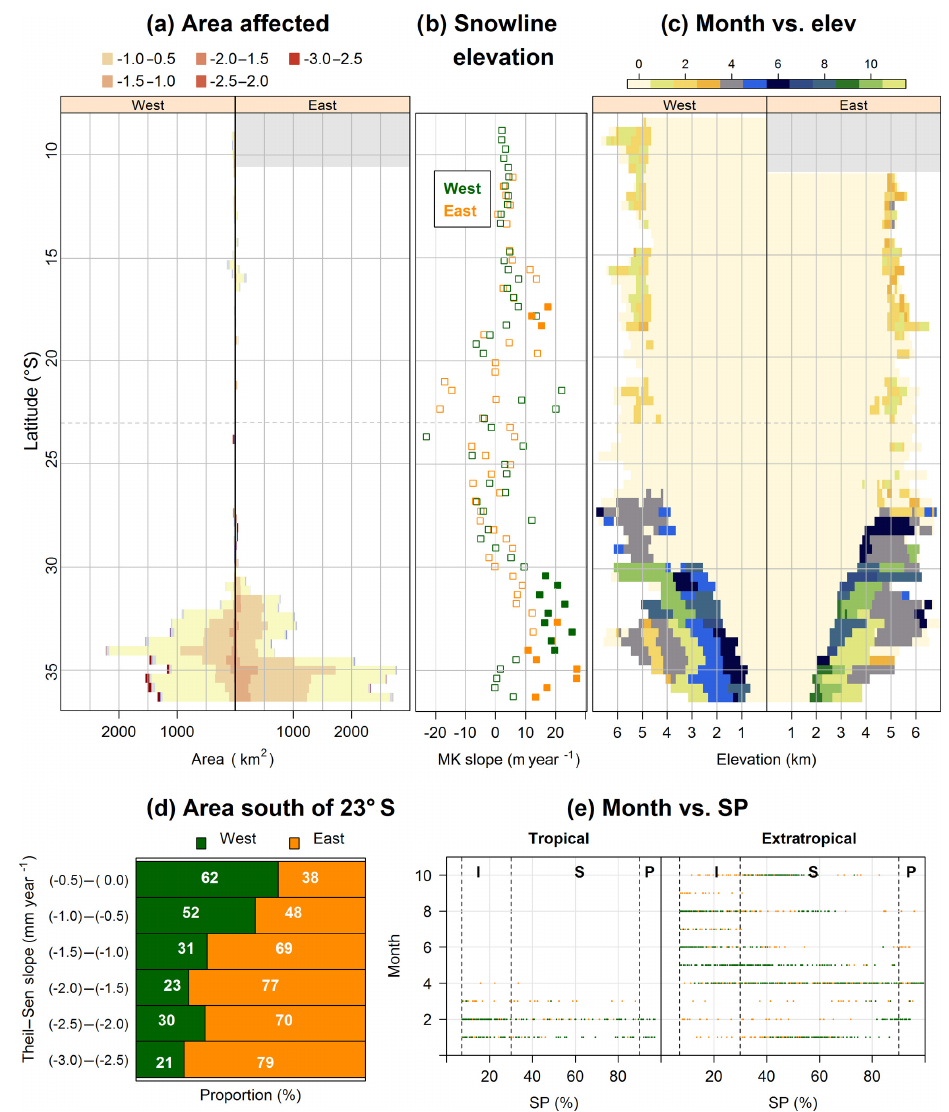
Figure 5. (a) Areas with significant trends in annual SP by side of the continental divide (west–east) and latitude band; (b) rate of change (Theil–Sen slope) in the elevation of the snowline (SP = 20%), where solid symbols have significant trends ( p ≤ 0.05); (c) months with the highest significant Theil–Sen slope from the Mann–Kendall trend analysis of monthly SP; (d) percent of area in each Theil–Sen slope category for west and east sides; and (e) months with greatest SP rate of change (slope) in tropical (north of 23 ◦ S) and extratropical (south of 23 ◦ S) latitudes for west (green) and orange (east) sides of the continental divide. Vertical dashed gray lines in panel (e) represent thresholds for intermittent (I), seasonal (S), and persistent (P) snow